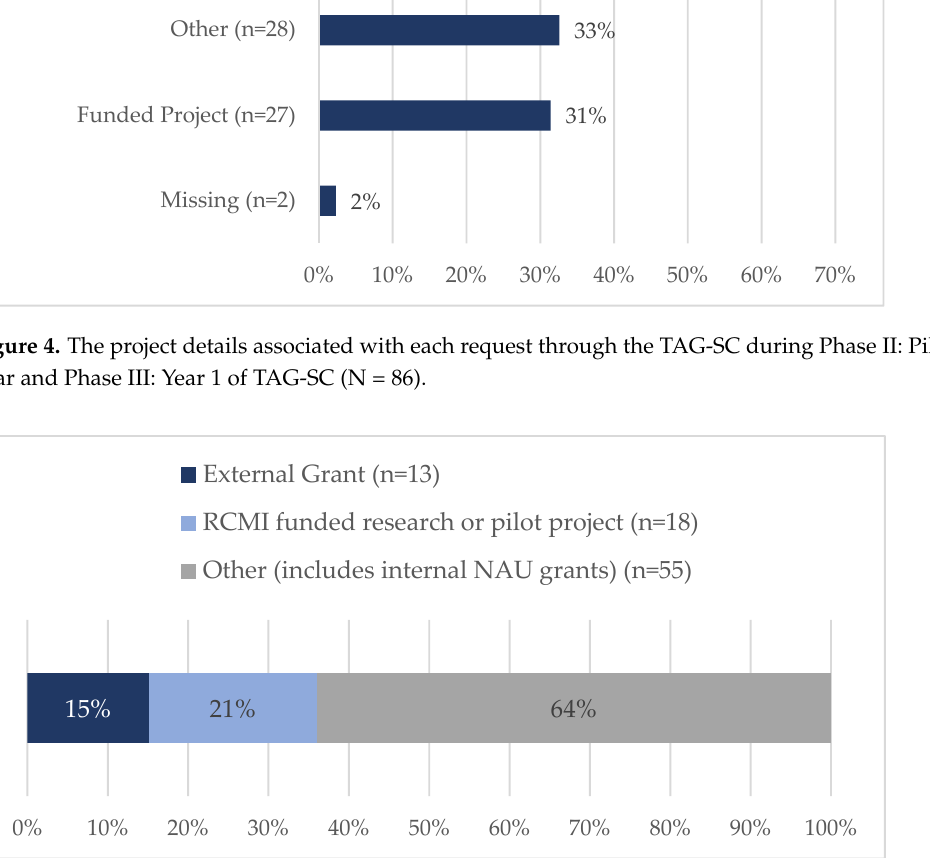
Figure 6. RCMI project content area for TAG-SC support (N = 86 *) during Phase II: Pilot Year and Phase III: Year 1 of TAG-SC. * Respondents could select more than one area. Thus the number of responses is greater than the number of respondents 4. Discussion We have presented the development process of a service center during the first five- year cycle of funding from NIMHD as an RCMI. The TAG-SC was created to serve the needs of university investigators who conducted health-equity related research. The team consisted of faculty and staff with expertise in research designs, methodologies, and ana- lytic techniques, which helped to increase the institution’s research capacity. The initial outcomes from the development of the TAG-SC directly align with the goals of the RCMI Program Specialized Centers [5]. As previously mentioned, these goals include (1) foster- ing environments conducive to career enhancement with a particular emphasis on the de- velopment of new and early career investigators; (2) enhancing the quality of all scientific inquiry and promoting research on minority health and health disparities; and (3) enhanc- ing institutional research capacity within the areas of basic Biomedical, Behavioral, and/or Clinical research. Results from the newly created TAG-SC suggest that the vast majority of research supported is Social/Behavioral and Clinical for ESIs and post-doctoral fellows on RCMI related projects. A key driver for the conceptualization of the REDCap system centered around eval- uation/tracking questions that enhanced SHERC’s ability to make a direct connection be- tween the work conducted through the TAG-SC and the goals of the RCMI program. Key constructs that inform RCMI goals include users (ESIs and post-docs), understanding the specific types of methodological needs and how they shift through time (longitudinal